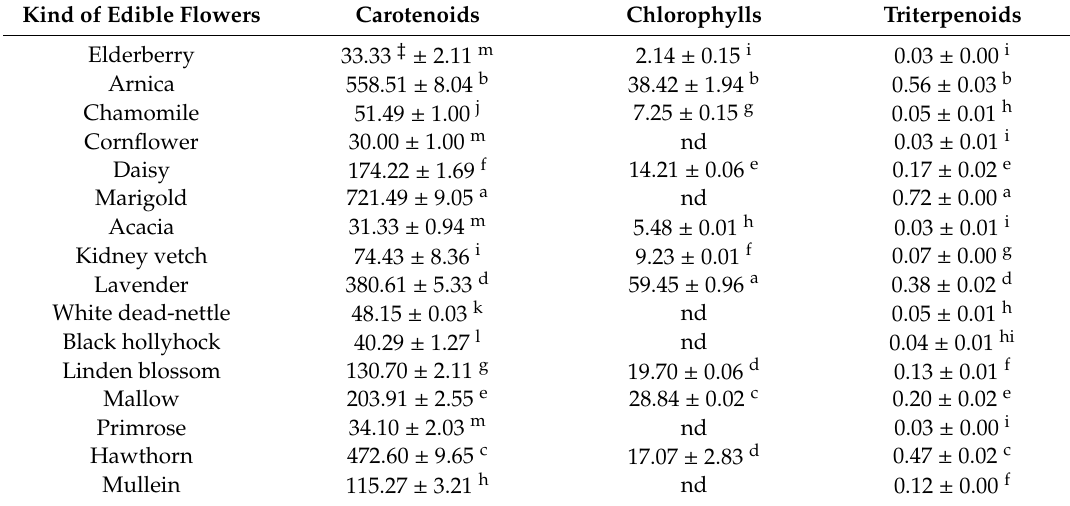
Table 2. Content of triterpenoids and tetraterpenoids (mg / 100 g dm) in 16 selected edible flowers. Kind of Edible